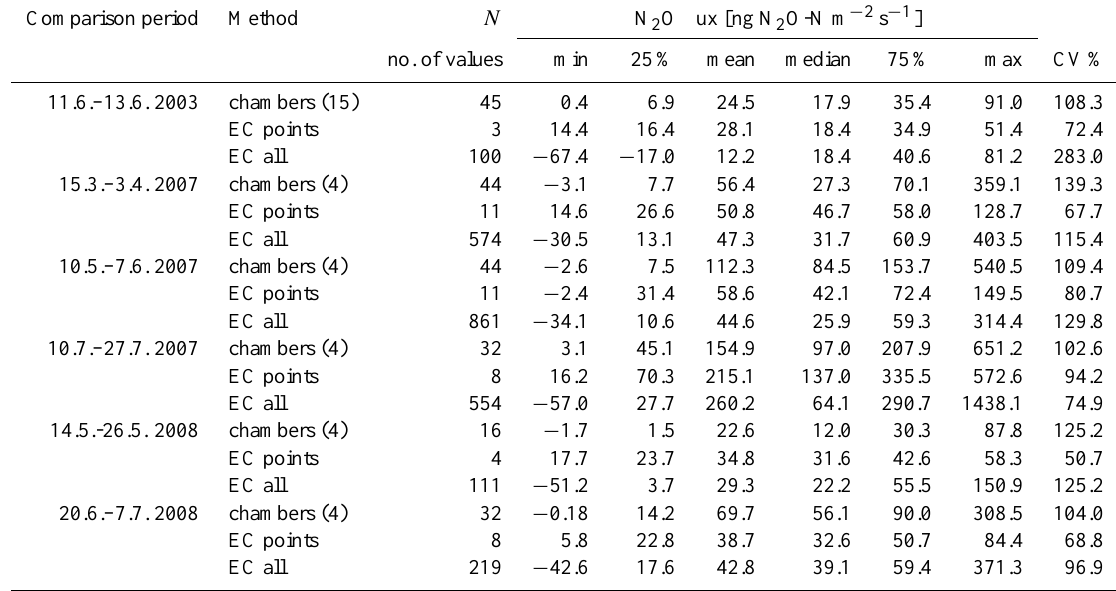
Table 2. Statistics of N 2 O fluxes from chambers and eddy covariance (EC) measurements for all 6 comparison periods. Numbers in brackets represent the number of chambers included in the comparison. EC points are eddy covariance hourly averages during chamber sampling (between 10:00 and 12:00); EC all are half hourly eddy covariance fluxes during the comparison period. The Coefficient of Variation is averaged over all measurements (30min or daily